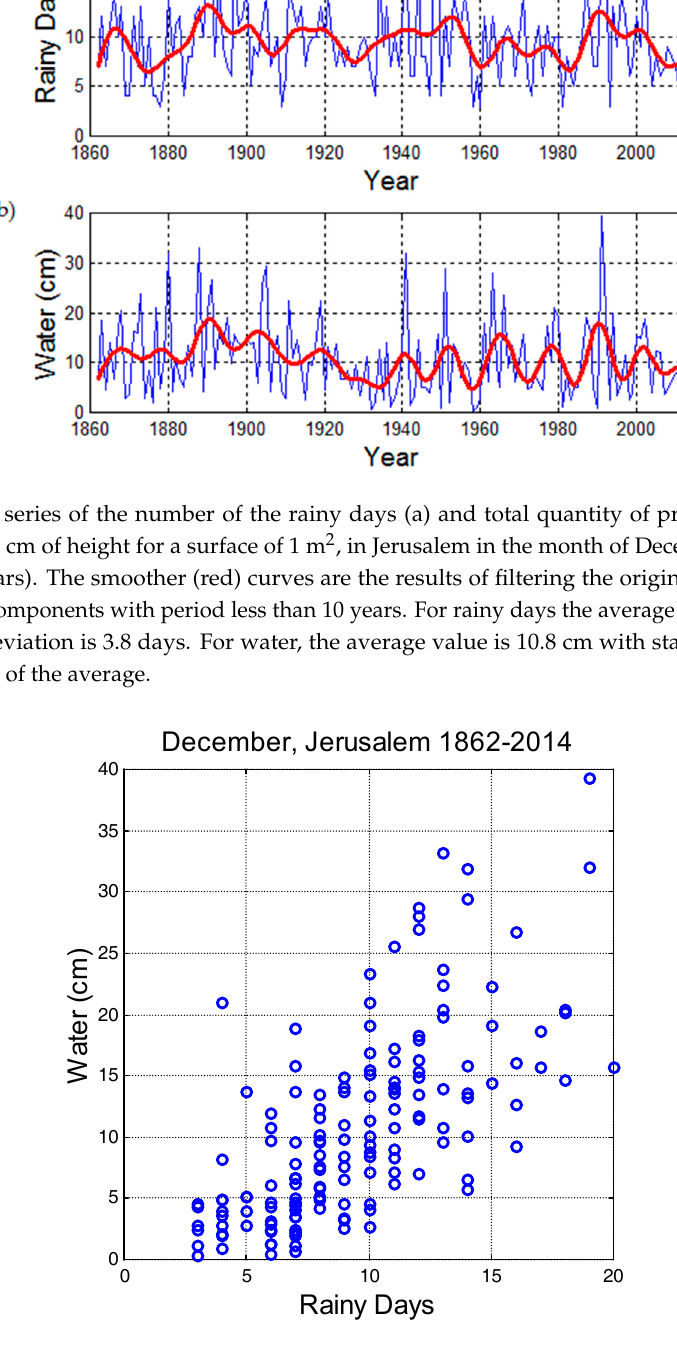
Figure 9. Scatterplot between the number of rainy days and the total quantity of precipitated water expressed in cm of height for a surface of 1 m 2 , in Jerusalem in the month of December, from 1862 to 2014 (153 years). The average number of rainy days is 9.5, the standard deviation 3.8 days; the average quantity of water is 10.8 cm with standard deviation 7.8 cm, i.e., 72% of the average. The correlation coefficient is 0.67.